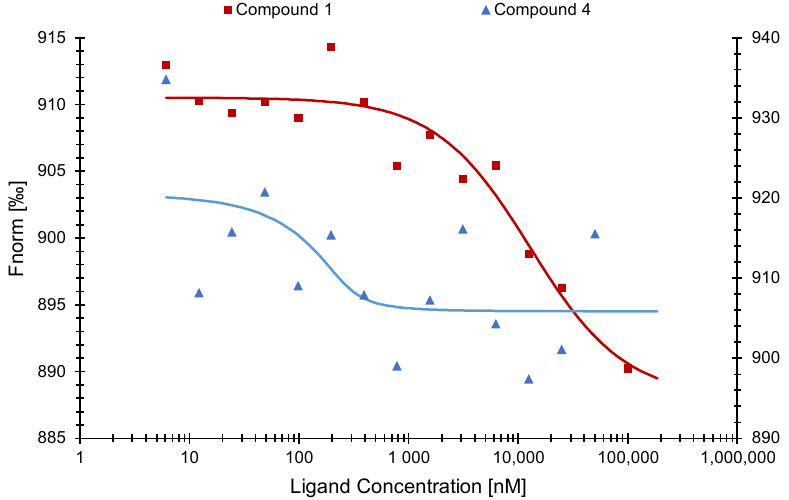
Figure 7. Binding curves of the SARS-CoV-2 NP omicron variant NP with compounds ( 1 ) ( left axis ) and ( 4 ) ( right axis ) as determined by microscale thermophoresis.